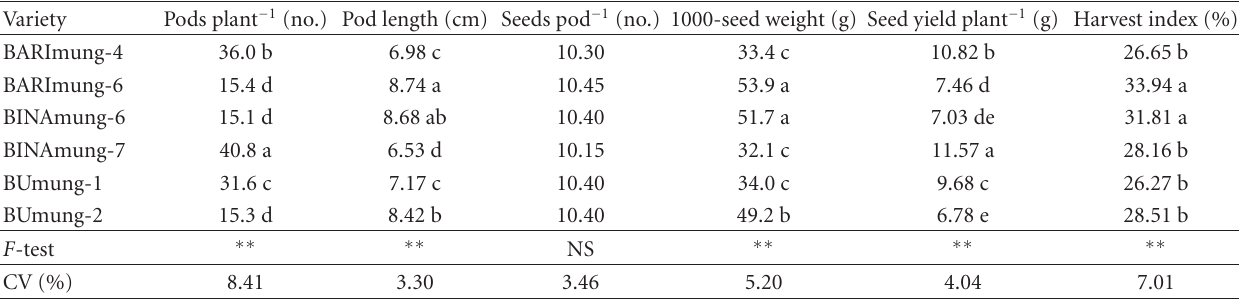
Table 2: Yield components and seed yield in six mungbean varieties (Mean over two years).